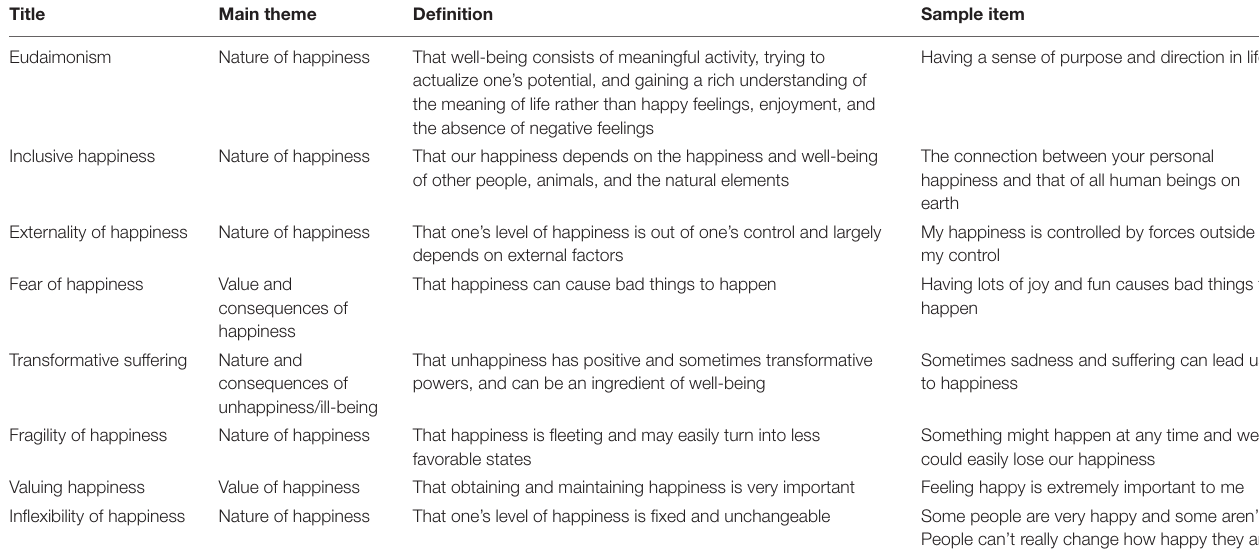
TABLE 1 | The lay conceptions of happiness examined in this article.